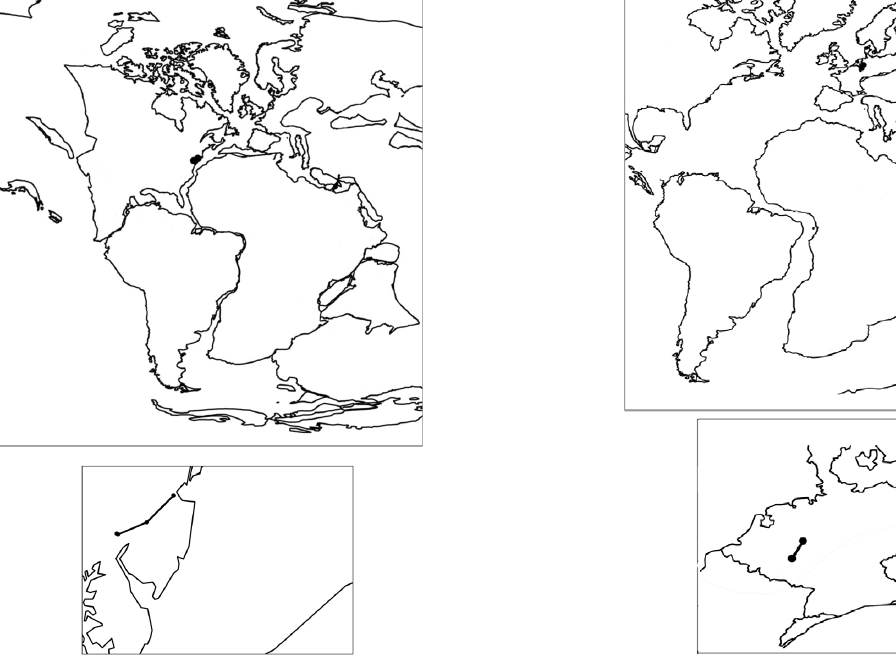
Fig. 5 - Sinemurian paleogeographic map showing the indi- vidual track of Trachymetopon liassicum , with a zoom of the occurrences